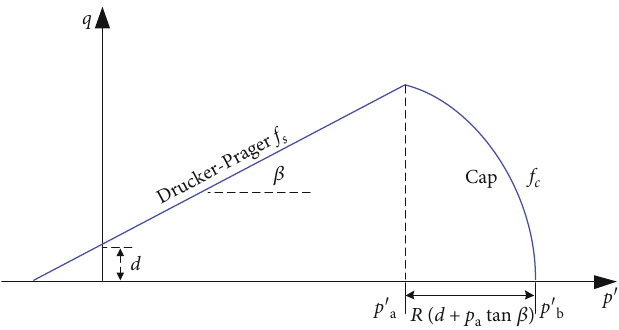
Figure 2: Yield surface of the Drucker-Prager/cap plasticity model in the p ′ − q plane.